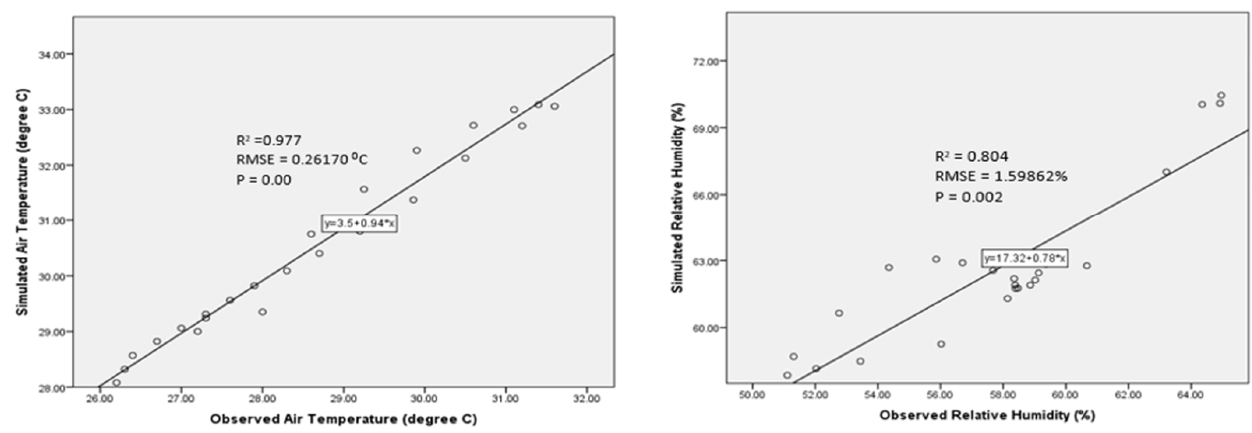
Figure 9. The validation between measured and simulated temperature ( left ) and RH ( right ) at SM.